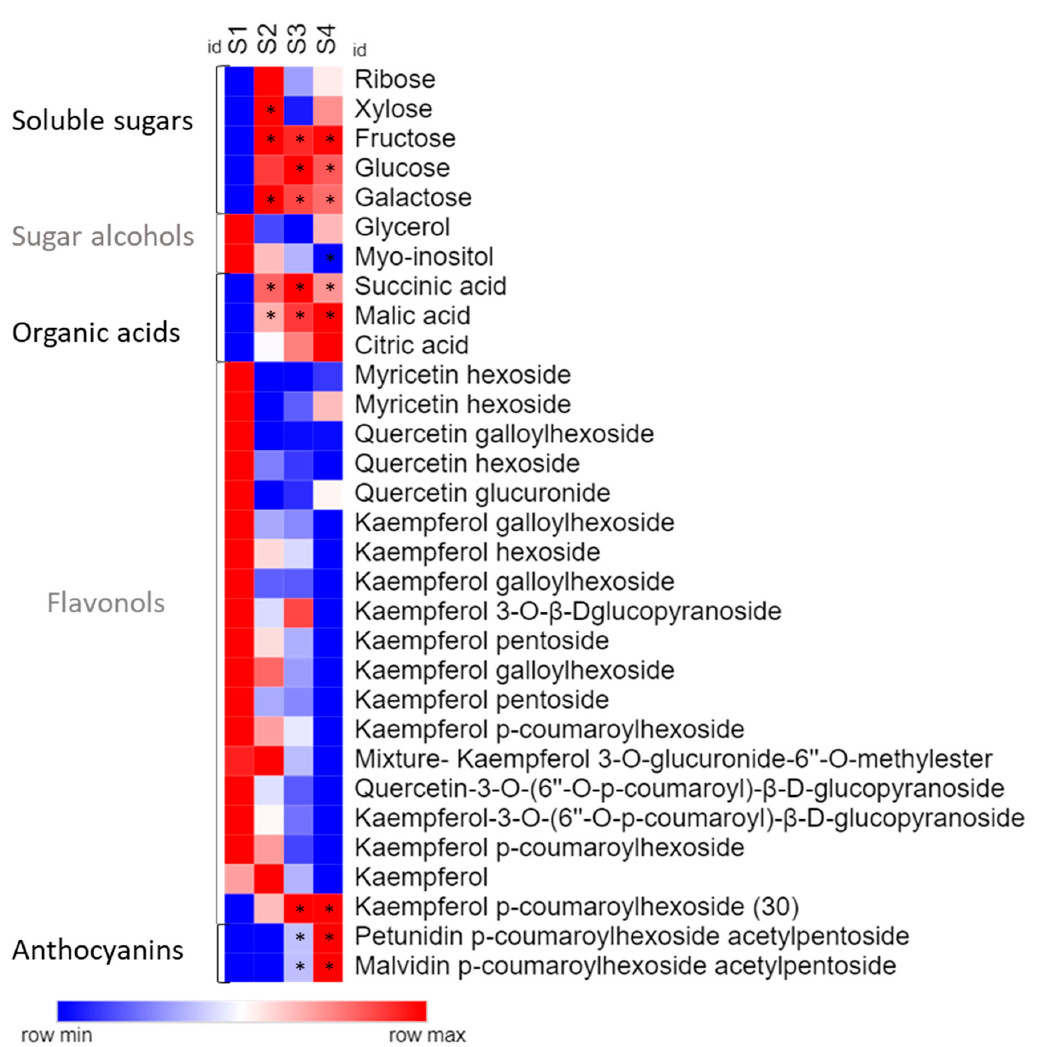
Figure 3. Heat map representing metabolic profile during the flower colour change in Pleroma raddianum . For each compound, asterisks indicate statistically significant di ff erences compared to S1 stage. Data of sugars and organic acid were obtained by chromatography coupled to mass spectrometry (GC-EIMS) and flavonoid data by Ultra Performance Liquid Chromatography-High-Resolution Mass Spectrometry (UPLC-HRMS). S1—buds (day 0), S2—white flowers (day 1), S3—pink (day 2), S4—purple (day 3).